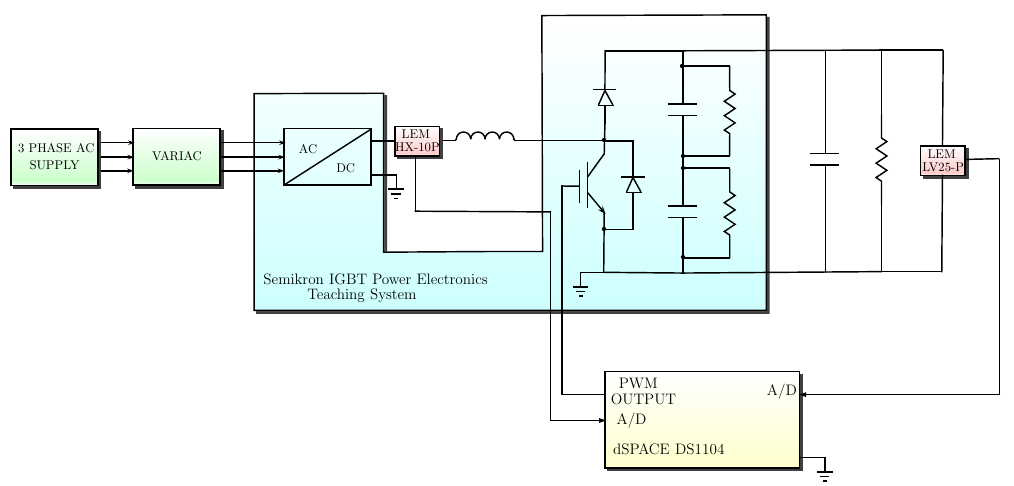
Figure 4. Block diagram of the experimental setup.